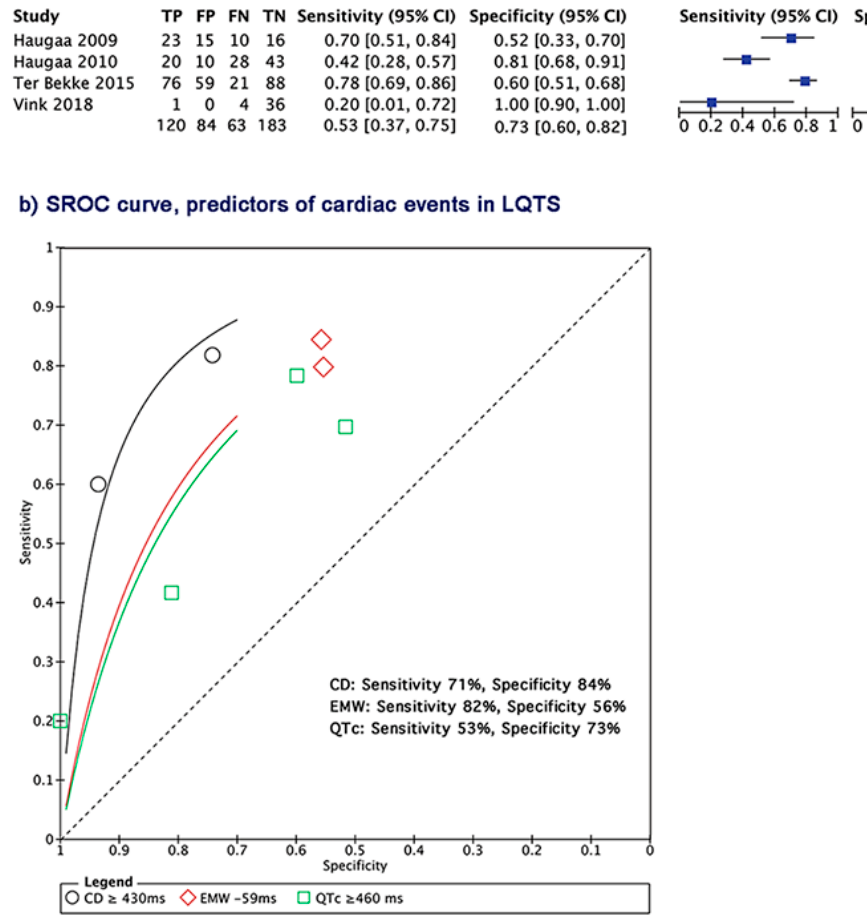
Figure 4. The Summary receiver operating characteristics (SROC) curve comparing CD, EMW, and QT C duration in predicting CE in LQTS. CD: contraction duration; EMW: electromechanical window; QT C : corrected QT interval .